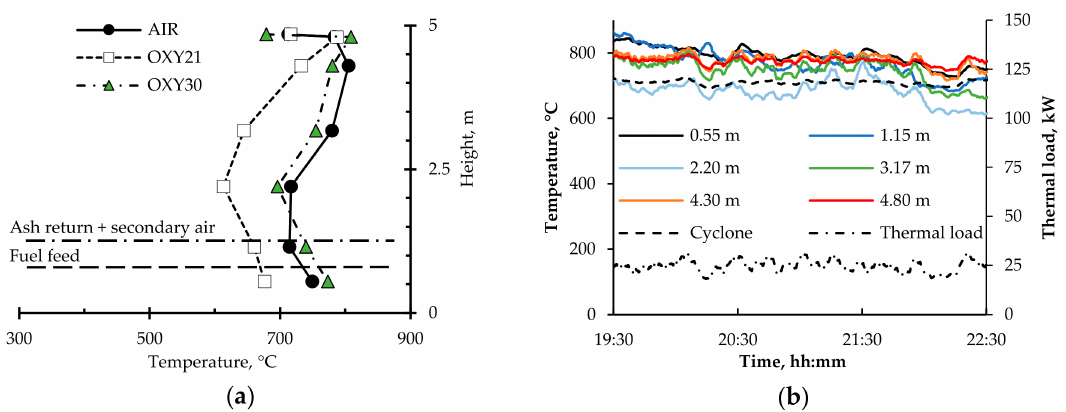
Figure 2. ( a ) Temperature distribution along the circulating fluidized bed (CFB) combustor riser and in the cyclone; ( b ) temperatures in the CFB cyclone exit and furnace at different heights. The temperatures deviance, due to fuel feeder, was up to 5%.